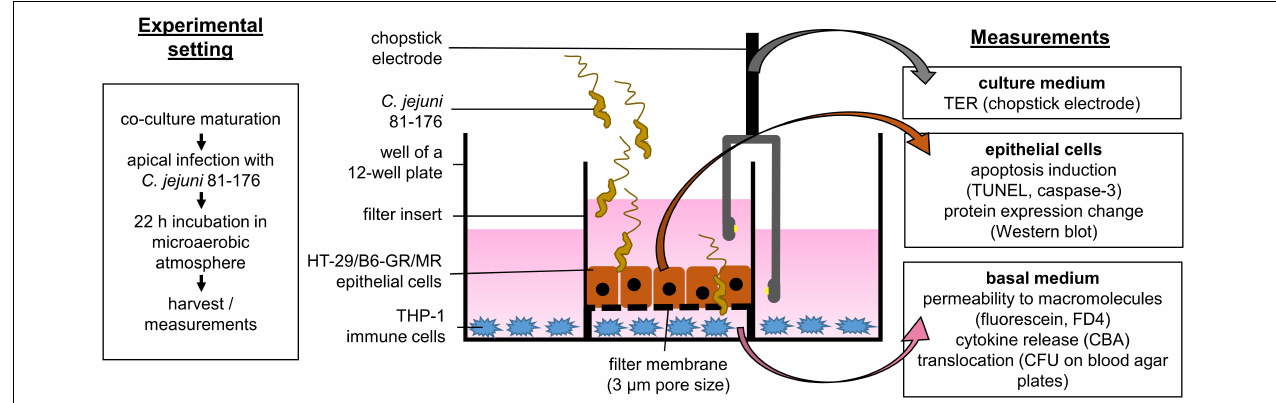
FIGURE 1 | Schematic sideview on the co-culture infection model. Epithelial cells HT-29/B6-GR/MR grown on filter supports were placed in a 12-well plate containing stimulated THP-1 immune cells. The co-culture was inoculated with C. jejuni 81-176 reference stain from the apical side. The infection experiments were performed under microaerobic conditions for 22 h with or without the apoptosis inhibitor Q-VD-OPh. After 22 h electrophysiological measurements were performed to assess the epithelial barrier integrity. Epithelial cells and basal medium were then harvested. The samples were further processed to evaluate the effects of the infection as well as the pathological mechanisms of epithelial barrier dysfunction caused by C. jejuni .